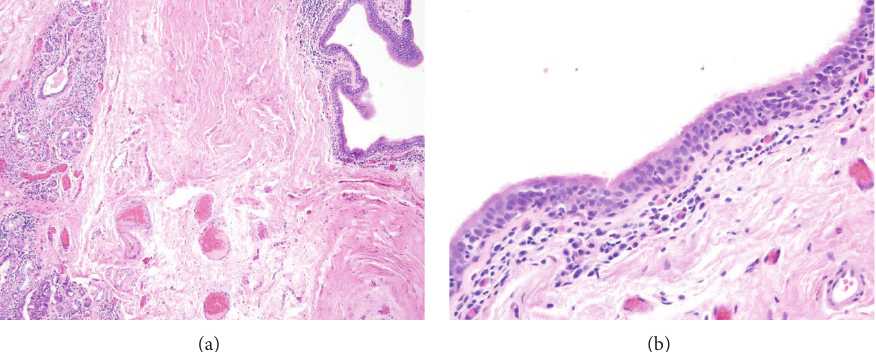
Figure 2: Lesion composed of cystic spaces surrounded by inflammatory infiltrate and adjacent minor salivary gland tissue ((a): HE × 100). Cystic spaces were lined by respiratory-type ciliated columnar epithelium with diffuse mild lymphocytic infiltrate ((b): HE × 400).